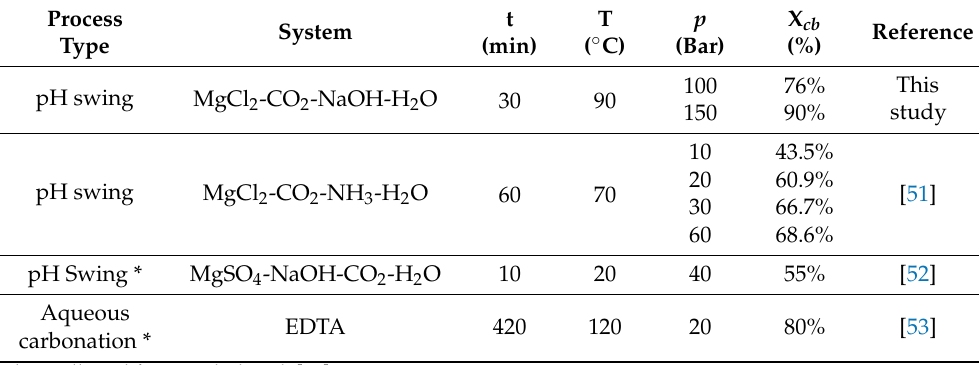
Table 8. Comparison of state-of-the-art literature on carbon dioxide capture